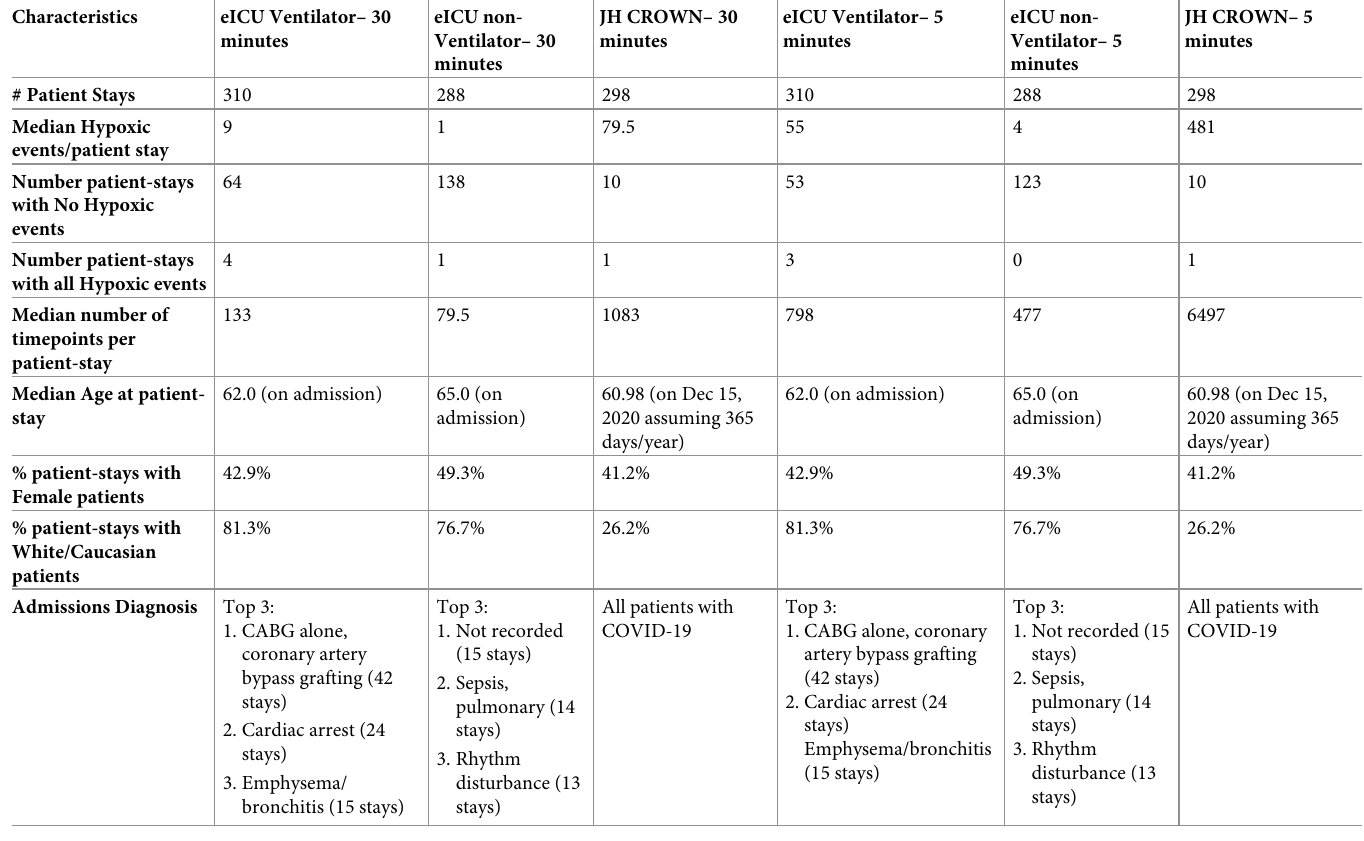
Table 1. Summary of patient characteristics used in model